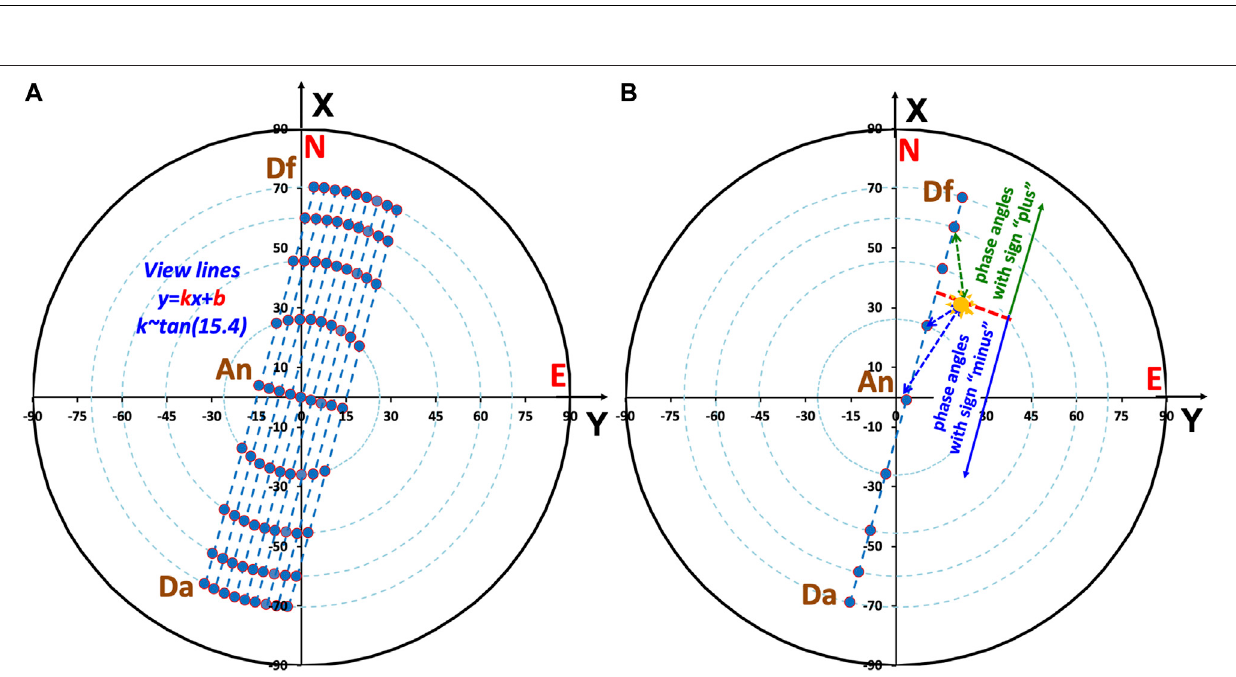
FIGURE2| MISRobservinggeometry.Herethe X andYaxespointtowardtheNorthandEast,respectively. (A) DirectionsfromgroundpixeltoMISRcamerasform viewlinesonthepolarplane, eachcharacterizingbyslope, k ,andintercept, b . (B) Sun-sensor geometryisparametrizedintermsthesolarzenithangle(SZA), intercept b and phase angle (PA), the latter is the angle between the directions to the Sun and sensor. We assign the sign “ plus ” to the phase angle if the MISR view direction approaches the direction to the sun from North (i.e., above the dotted red line perpendicular to the MISR view line), and “ minus ” otherwise.